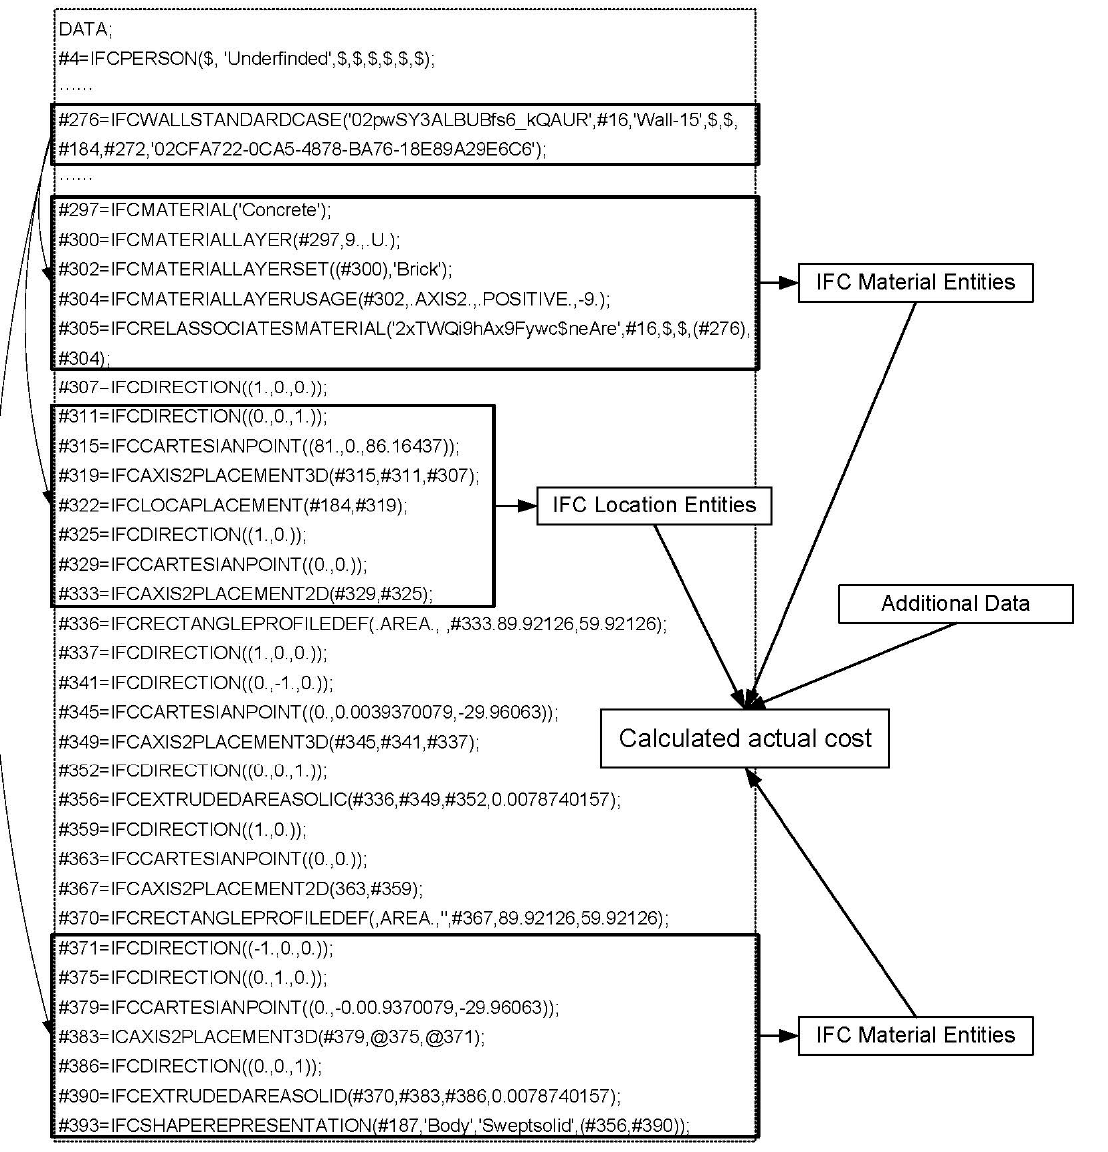
Figure 5. Industry Foundation Class (IFC) mapping process.